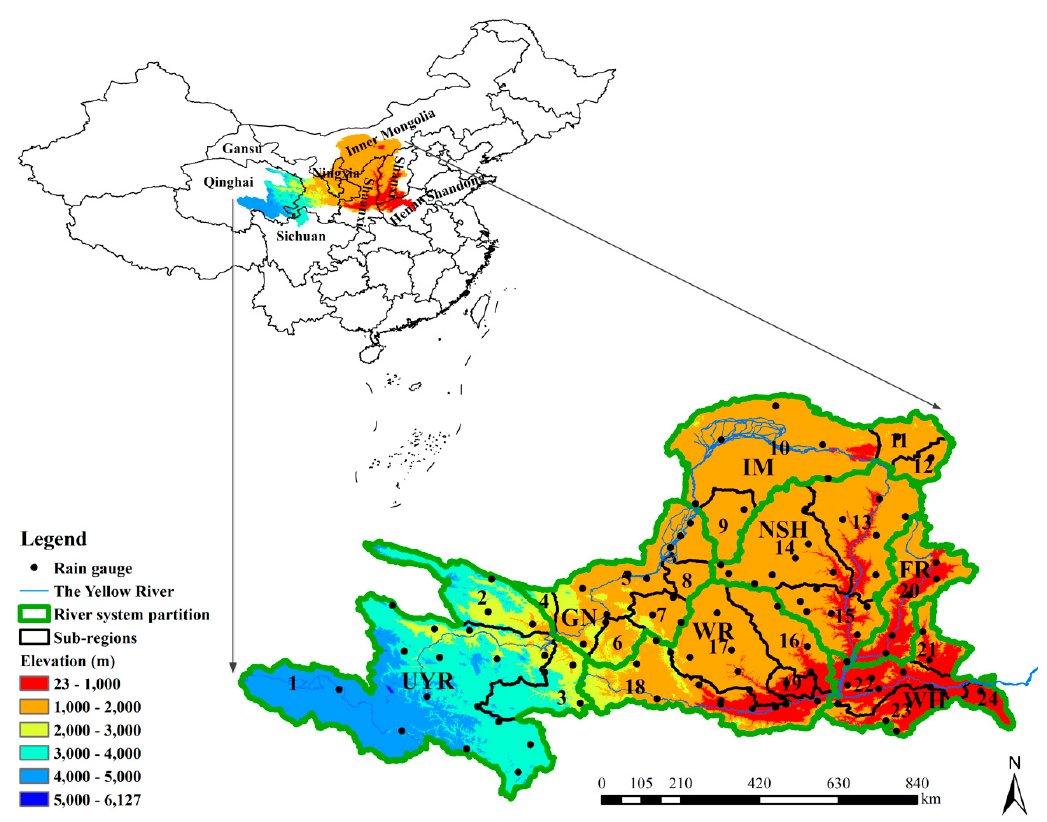
Figure 1. Geographical location, elevation, rain gauge distribution, water system partition and sub-basins of the Yellow River basin. UYR, GN, IM, NSH, WR, FR, and WH are the upper Yellow River, Gansu–Ningxia water system, Inner Mongolia water system, Northern Shaanxi water system, Wei River Basin, Fen River Basin, Western Henan water system, respectively. The No and the name of the sub-basins: 1, Yellow River Source. 2, Huang River. 3, Tao River. 4, Zhuanglang River. 5, Tributary 1 in upper Yellow River. 6, Zuli River. 7, Qingshui River. 8, Kushui River. 9, Dusitu River. 10, Tributary 2 in upper Yellow River. 11, Dahei River. 12, Hun River. 13, Tuwei River, Kuye River, etc. 14, Wuding River. 15, Qingjian River and Yanshui River. 16, Beiluo River. 17, Jing River. 18, Wei River. 19, Shichuan River. 20, Fen River. 21, Qin River. 22, Tributary in middle Yellow River. 23, Yiluo River. 24, Ying